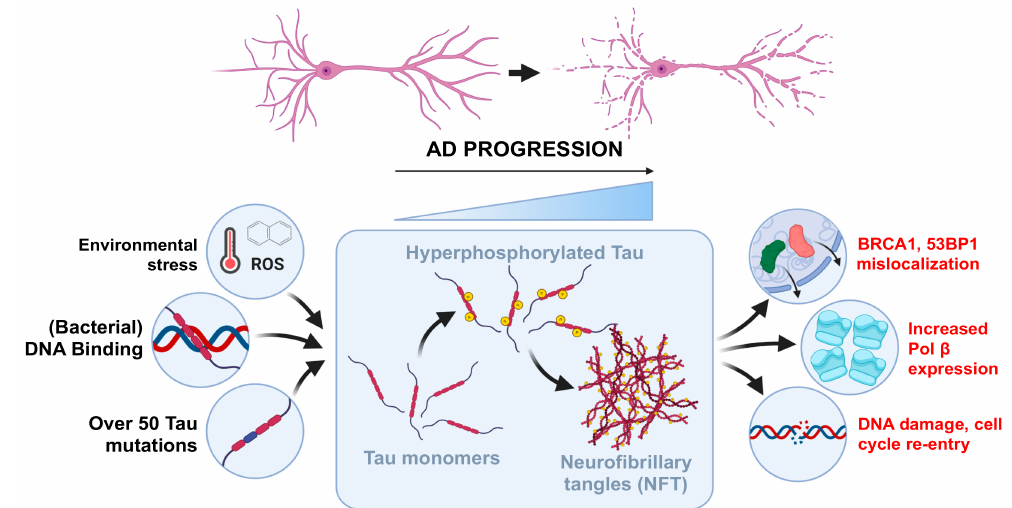
Figure 2. Tau, interaction with DNA damage and AD progression. DNA insults, such as caused by reactive oxygen species (ROS), bacterial infections and tau mutations, can cause hyperphosphorylation of tau and the formation of neurofibrillary tangles (NFT) in AD-induced progression. This particular situation drastically negatively influences DNA damages and repair pathways